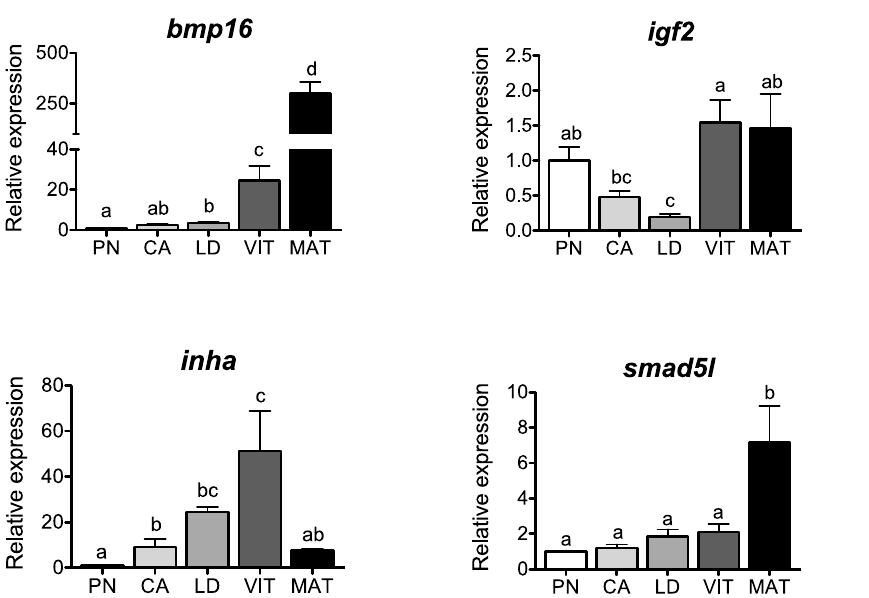
Fig. 7. Expression profiles of genes associated with growth factor signaling during major stages of oogenesis in coho salmon. Messenger RNA levels were analyzed by qPCR and data were normalized to the geometric mean of four reference genes ( eef1a , ctsd , ctsz and actb ). PN, perinucleolus stage follicles; CA, cortical alveolus stage follicles; LD, lipid droplet stage follicles; VIT, mid-vitellogenic stage follicles; MAT, postvitellogenic/preovulatory stage follicles. Bars not sharing the same letter are significantly different (P , 0.05; n 5 4 fish/stage for PN-, CA-, LD-, and VIT-stages, n 5 3 fish for MAT-stage, mean ¡